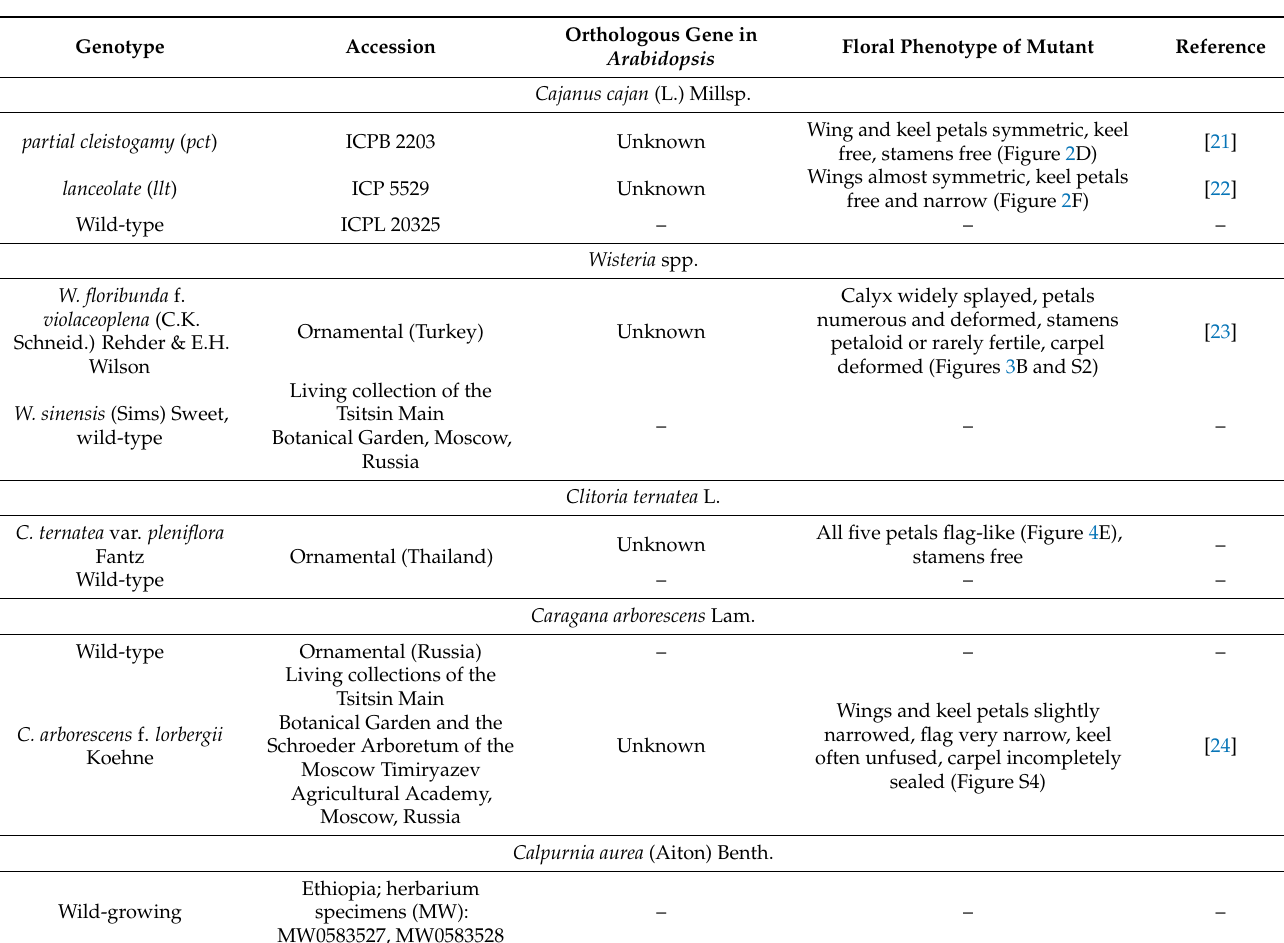
Figure 4. Floral morphology ( A , E ), floral diagrams ( B , F ) and SEM images of identical areas on a border between floral cup and androecium ( C , D , G ) in wild-type ( A – D ) and ‘double’ ( E – G ) flowers of Clitoria ternatea . The position of illustrated area in a resupinated flower is schematically represented on ( H ). A marginal part of ridge-like structure of wild-type flower is enlarged on ( D ). Key: arrows = rupture caused by the dissection; double arrowhead = place illustrated in ( C , G ); ad = adaxial side; ca = carpel; fc = floral cup; r = ridge; st = stamens [note absence of staminal fusion on ( F )]. For color designations on floral diagrams and ( H ), see Figure 1. Scale bars: 300 μm ( C , G ), 30 μm ( D ). Photos: Arturo C. Mendoza ( A ), Janardhan Uppada ( E ). Flowers of Cajanus accessions were collected on the experimental plot of the International Crops Research Institute for Semi-Arid Tropics (ICRISAT, Hyderabad, India). Anomalous flowers of Wisteria were sampled in the living collection of the Nezahat Gökyiğit Botanical Garden (Istanbul, Turkey), while normal flowers were sampled from the specimen in the living collection of the Tsitsin Main Botanical Garden (Moscow,